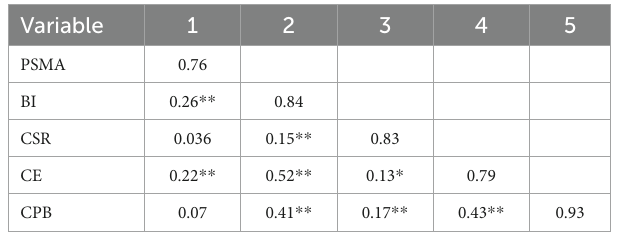
TABLE 2 Variable correlations and the square root of AVE.